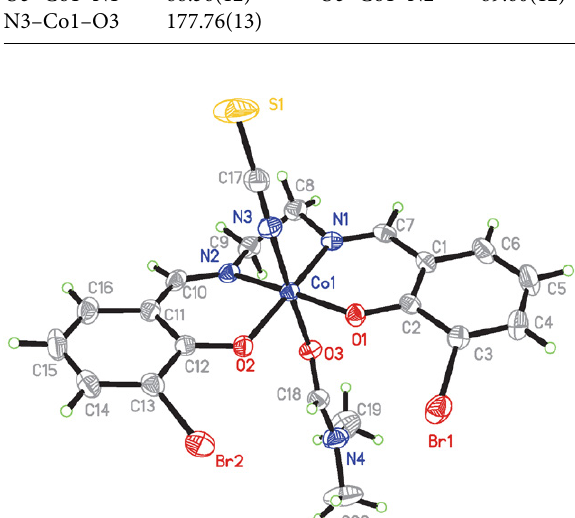
Fig. 4. Molecular structure of complex 2 with thermal ellipsoids of 30% probability